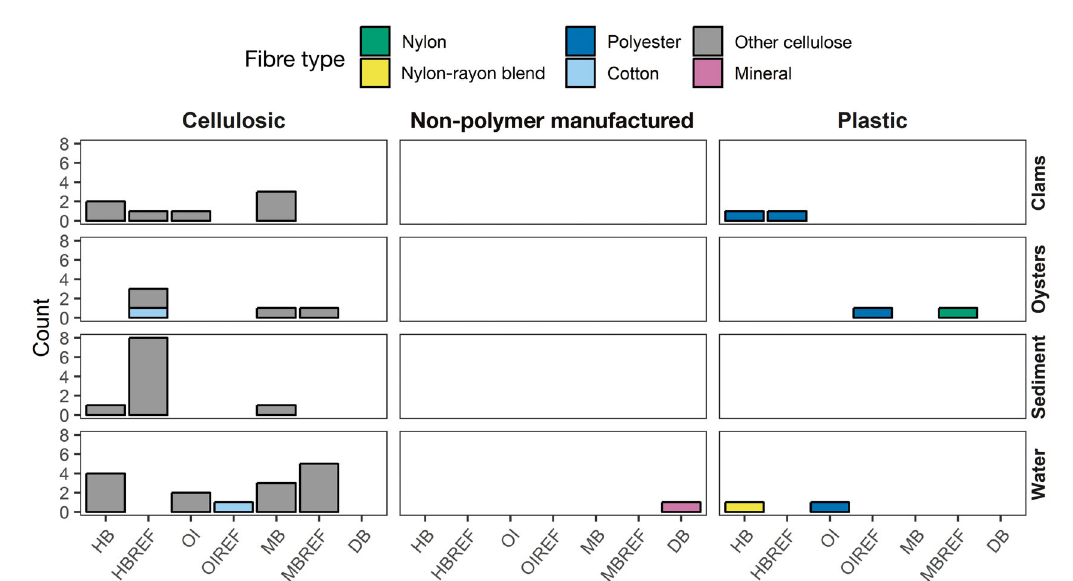
Fig. 4. Fourier-transform infrared (FTIR) spectroscopy results for 44 putative microplastic particles confirming that 6 were plas- tic and composed of nylon, polyester, or a nylon-rayon blend. Material class is listed across the top and sample type across the right-hand side. Non-polymer manufactured materials include the 1 mineral fibre detected and cellulosic materials cover cot- ton and all other cellulose-based fibres, including natural (e.g. naturally occurring plant fibres) and semi-synthetic (i.e. rayon and viscose) that could not be reliably separated by FTIR spectroscopy. See Fig. 1 for site